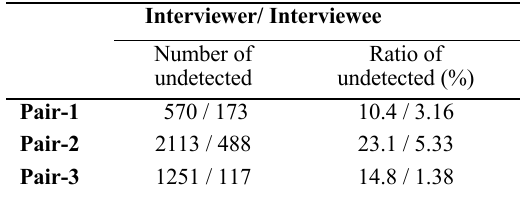
Table 4: The number and ratio of image-frames that face could not be detected.